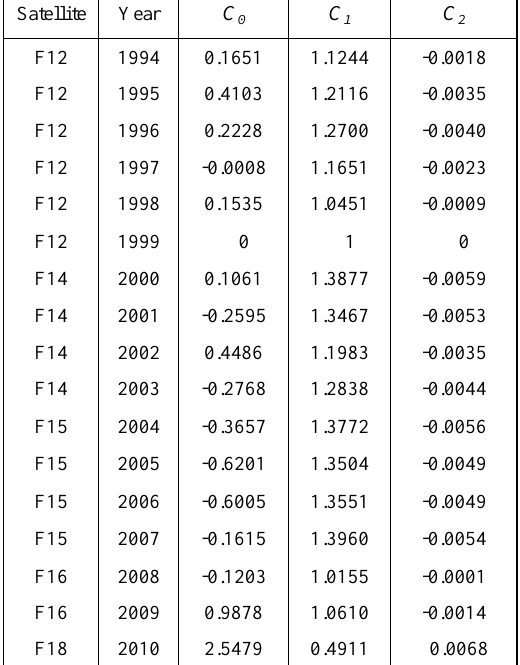
Table 1. The coefficients from 1994 to 2010 derived by